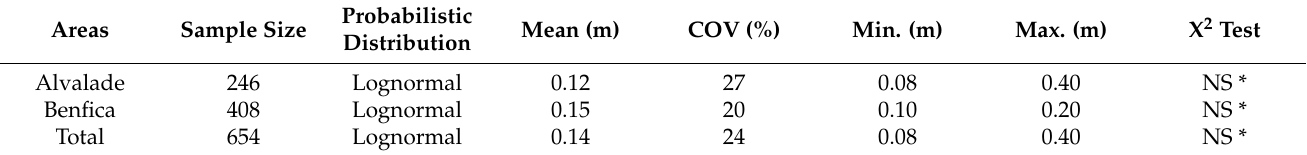
Table 6. Probabilistic distribution of slab thickness for the RC building stock of each parish.